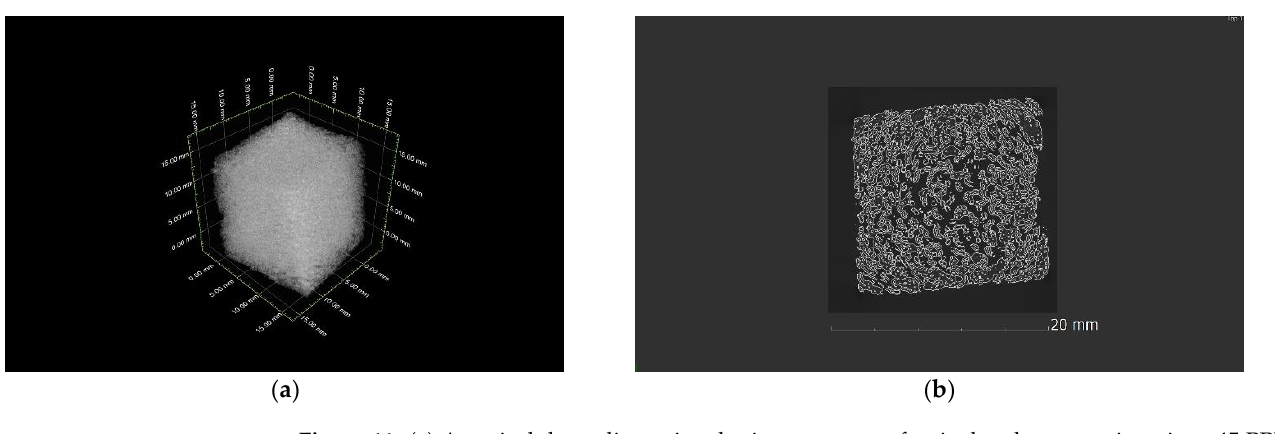
Figure 11. ( a ) A typical three-dimensional microstructure of reticulated porous zirconia at 45